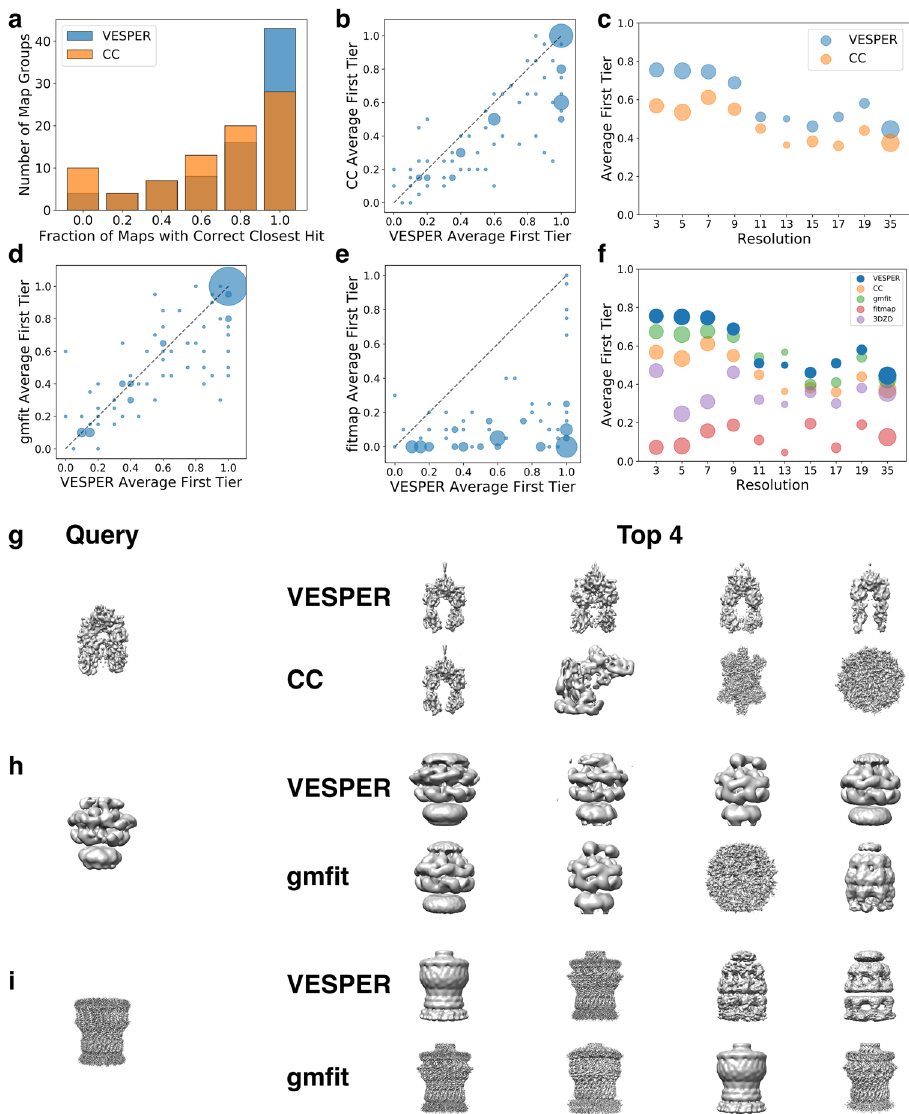
Fig. 2 Performance on global map search. a – c comparison of VESPER with the DOT (blue) score and CC (orange). a The number of map groups classi fi ed by the fraction of member maps that retrieved a correct map as the top hit. b The fi rst tier hit fraction for each group. The area of a data point is proportional to the number of groups. c The average fraction of correct hits within the fi rst tier on maps at different resolutions. d Comparison between VESPER and gm fi t on the fi rst tier hit fraction. e Comparison between VESPER and fi tmap on the fi rst tier hit fraction. f The average fi rst tier hit fraction for maps in each resolution bin by VESPER with the DOT score (blue), CC (orange), gm fi t (green), fi tmap (red), and EM-SURFER (3DZD; purple). The resolution of the query map was considered. g An example of a query map where the DOT score performed better than CC. The query map is PikAIII (EMD-5664). The top four retrieved maps by VESPER with the DOT score were all from PikAIII: EMD-5649, EMD-5663, EMD-5651, and EMD-5666, in this order. On the other hand, only 1 out of the top 4 retrieved maps by CC were PikAIII: EMD-5649 (PikAIII), EMD-6443 ( Tetrahymena telomerase), EMD- 6635 (glutamate dehydrogenase), EMD-5145 (bovine TriC), in this order. h An example of map retrieval where VESPER performed better than gm fi t. The query is a map of ClpB bound to ClpP (EMD-2558). All the four maps retrieved in the fi rst tier by VESPER were ClpB-ClpP: EMD-2557, EMD-2556, EMD- 2560, EMD-2559 in this order. With gm fi t, only two within the top four retrieved maps were the ClpB-ClpP: EMD-2559 (ClpB-ClpP), EMD-2560 (ClpB- ClpP), EMD-5145 (bovine TriC), EMD-2327 (GroEL-GroES). i An example of map retrieval where gm fi t performed better than VESPER. The query is a